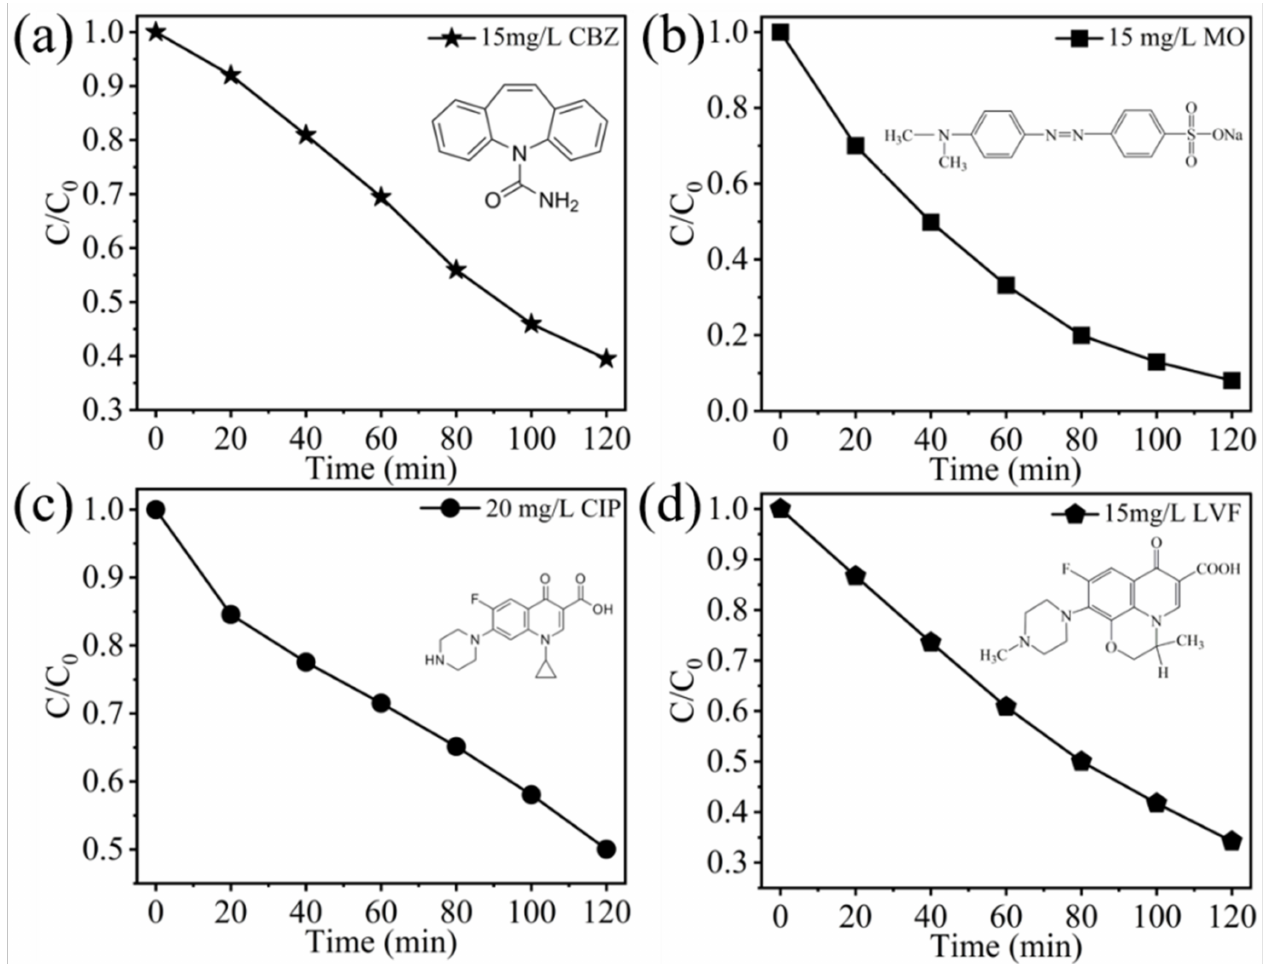
Figure 12. PEC degradation performance of ( a ) carbamazepine (CBZ, 15 mg/L); ( b ) methyl orange (MO, 15 mg/L); ( c ) ciprofloxacin (CIP, 20 mg/L); and ( d ) levofloxacin (LVF, 15